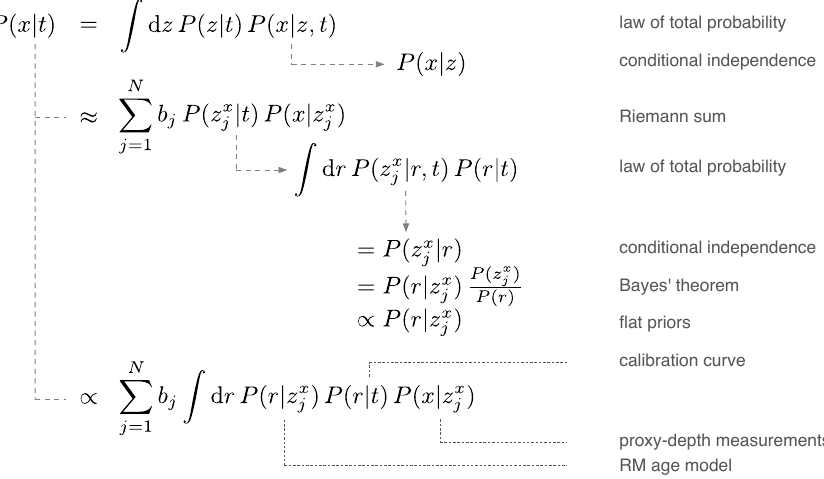
the second one, i.e., with a trivial diagonal calibration curve 160 without uncertainty.